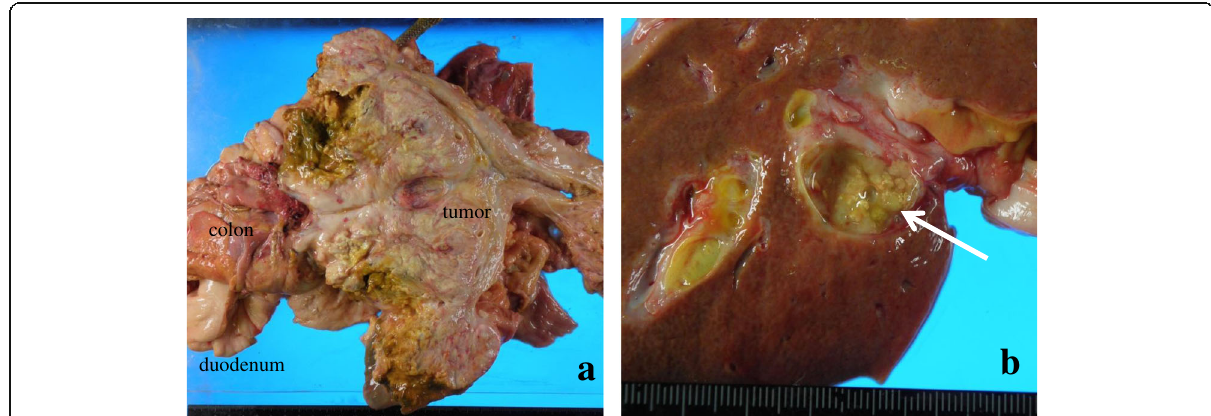
Fig. 3 Macroscopic findings of the large tumor in the hepatoduodenal ligament and liver. a Large tumor with invasion to the duodenum and transverse colon. b Intraductal tumor (arrow) at the proximal side of the bile ducts in segment 2